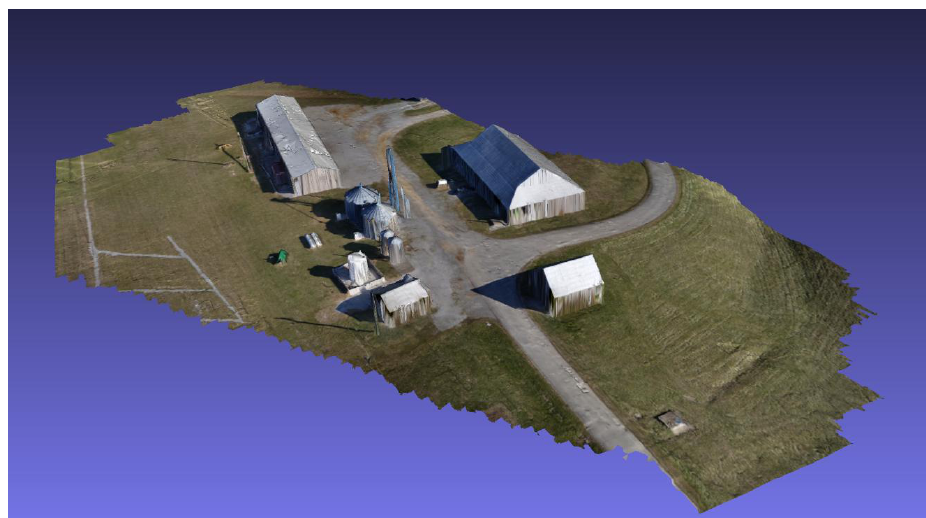
Figure 8. A 3D reconstruction produced from drone imagery captured at the Virginia Tech Kentland research